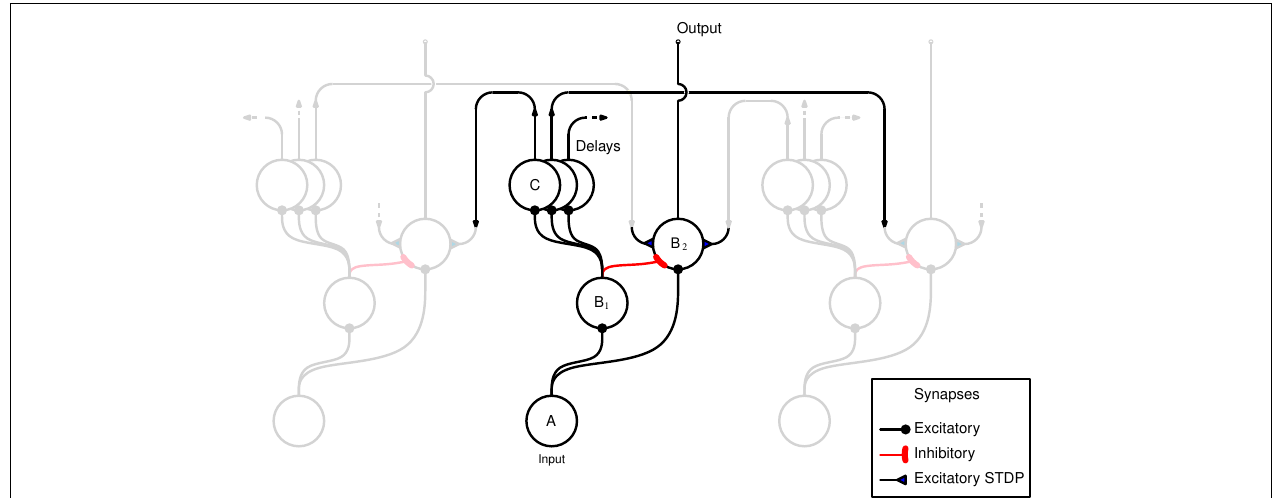
FIGURE 1 | Schematic representation of the network as implemented in hardware and software. Neurons are arranged in groups representing positions on the tonotopic axis. Three channels only are shown, and of these only the central channel is labeled for clarity. The two flanking channels are